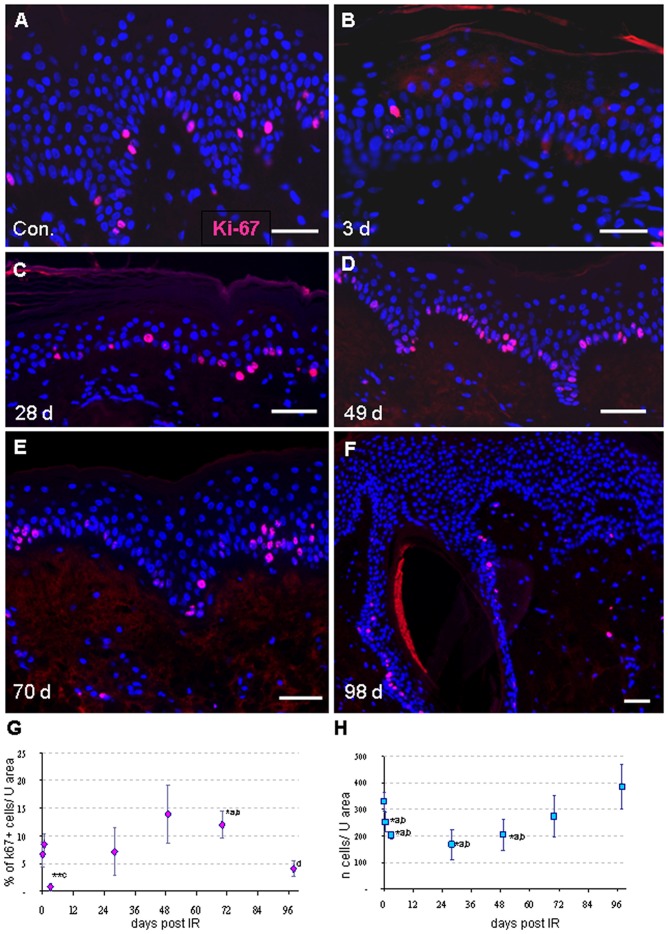
IR-induced changes of proliferation index (Ki67) and in epidermal cellularity as displayed by nuclear counterstaining (DAPI, blue).(A) Control minipig skin samples showing Ki67-positive cells (pink) at the basal layer of the densely populated epidermis. (B) Minipig skin sample 3 days post IR displaying a dearth of replicating cells, while at 28 (C), 49 (D) and 70 (E) days proliferating cells are abundant. (F) At 98 days epidermal hyperplasia was associated with a drop of replicating cell number. Magnification bar for all details: 20 µm. (G) Frequency of Ki67 positive (+) cells per unit area revealing a significant reduction (**p<0.001) of Ki-67-positive cells 3 days after IR relative to control and 4 h. A raise of replicating cells was noted ≥ 49 days post IR being significant at day 70 relative to control and the earlier time points. The fraction of replicating cells was significantly reduced at 96 days post IR, being associated with epithelia hyperplasia. (H) Epidermal cellularity during the time window investigated as determined by enumeration of the total number of DAPI-positive nuclei (blue, A-F) of keratinocytes per 169 µm unit contour length (average of 3 pigs). There is a significant decrease in the cellularity of the epidermis from 3 days up to 28 days post IR, as compared to control. A constant raise of the cellularity of the epidermis was observed from 28 days post irradiation onwards. The mean and SD of 3 pigs is given, except for 3 days (2 pigs); *, p<0.05; **, p<0.001. (G,H) Significant difference: a relative to control, b relative to 98 d, c relative to all other time points, d relative to 4 h, 3d, 48d and 72 days.